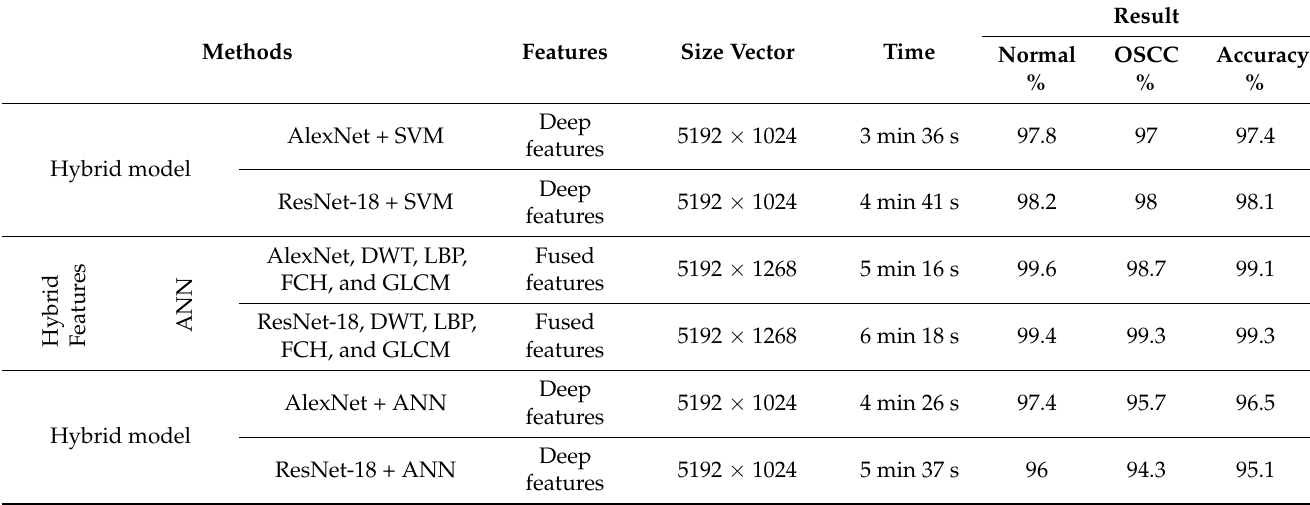
Table 6. Results for all proposed systems for OSCC data set diagnostics.